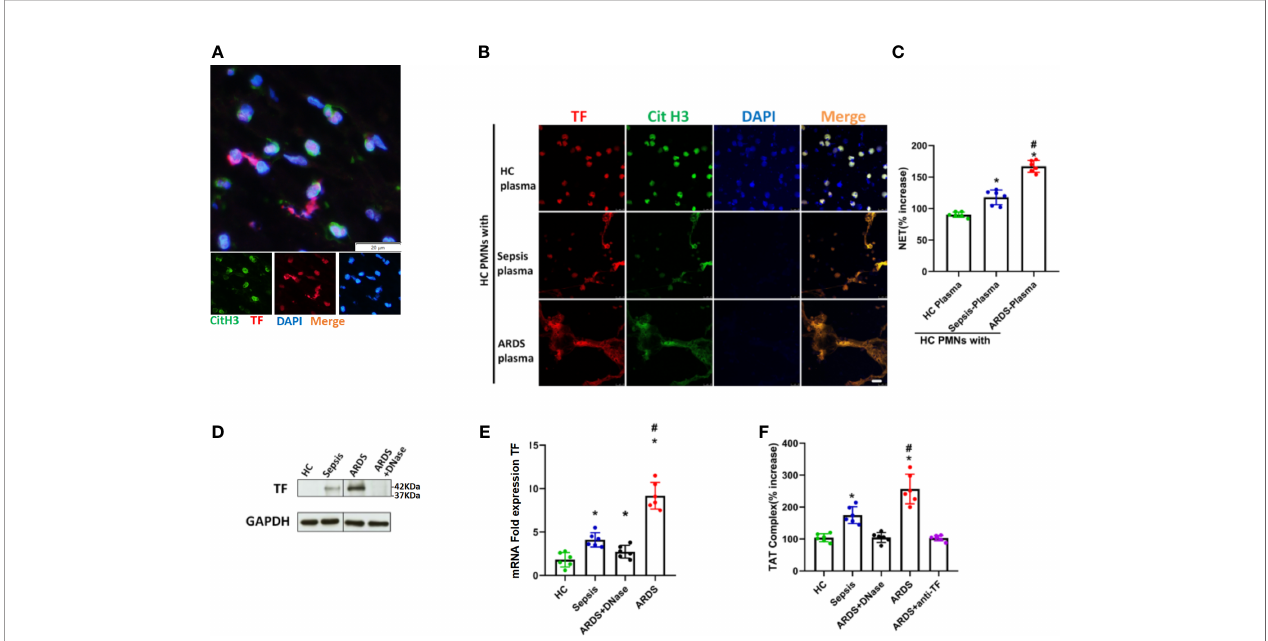
FIGURE 3 | Intracellular TF in polymorphonuclear neutrophils of ARDS patients is associated with NET formation. (A) Fluorescence imaging of lung thrombi in ARDS mice. The sections were immunostained with TF (red) and CitH3 (green), and DAPI (blue) was used to counterstain nuclei. (B) Plasma of healthy controls (HC), sepsis or ARDS patients was cocultured with polymorphonuclear neutrophils (PMNs) in HC. Fluorescence imaging of PMNs in the three groups. The sections were immunostained with TF (red) and CitH3 (green), and DAPI (blue) was used to counterstain the nuclei. (C) An increase in NETs was detected by coculture with different plasma samples (n=6). (D) Western blots for TF expression in the HC, sepsis, ARDS or ARDS+DNase groups (n=6). (E) mRNA fold change for TF expression in HC, sepsis, ARDS or ARDS+DNase groups (n=6). (F) TAT complex progression in the HC, sepsis, ARDS+DNase, ARDS, or ARDS+ anti-TF groups (n=6). P < 0.05 (*) and P < 0.05 ( # ) compared to baseline healthy controls and the sepsis group were considered statistically signi fi